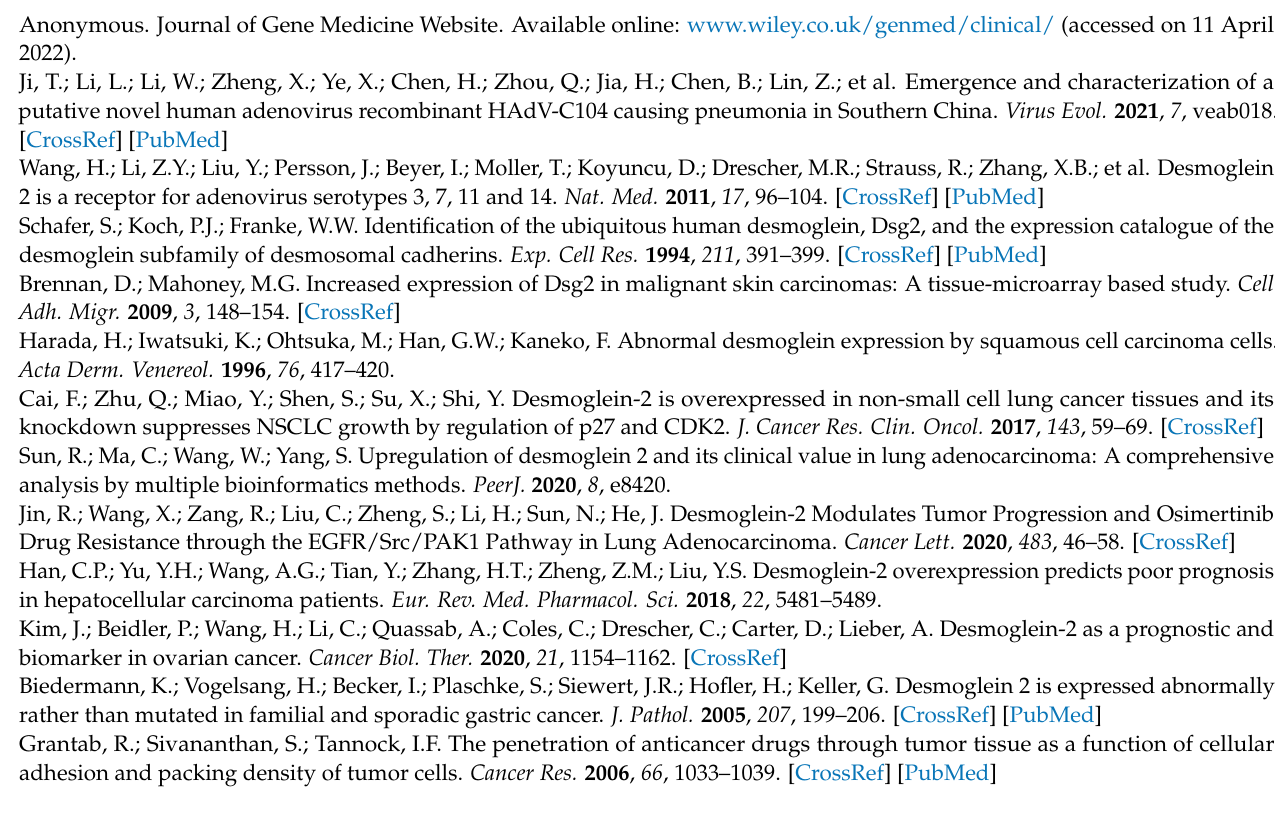
Figure S4: Amino acid alignment of penton base of Ad5 and Ad3. The RGD loop is underlined.